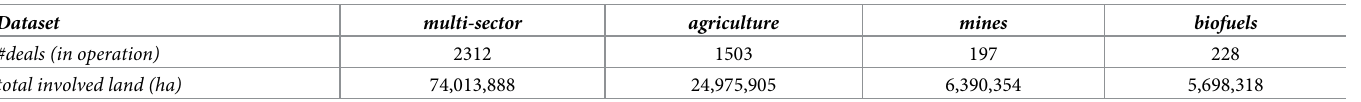
Table 1. Characteristics of the Land Matrix Initiative datasets (as of 17 March 2022). The total involved land refers to the total size of deals currently in operation for each dataset.